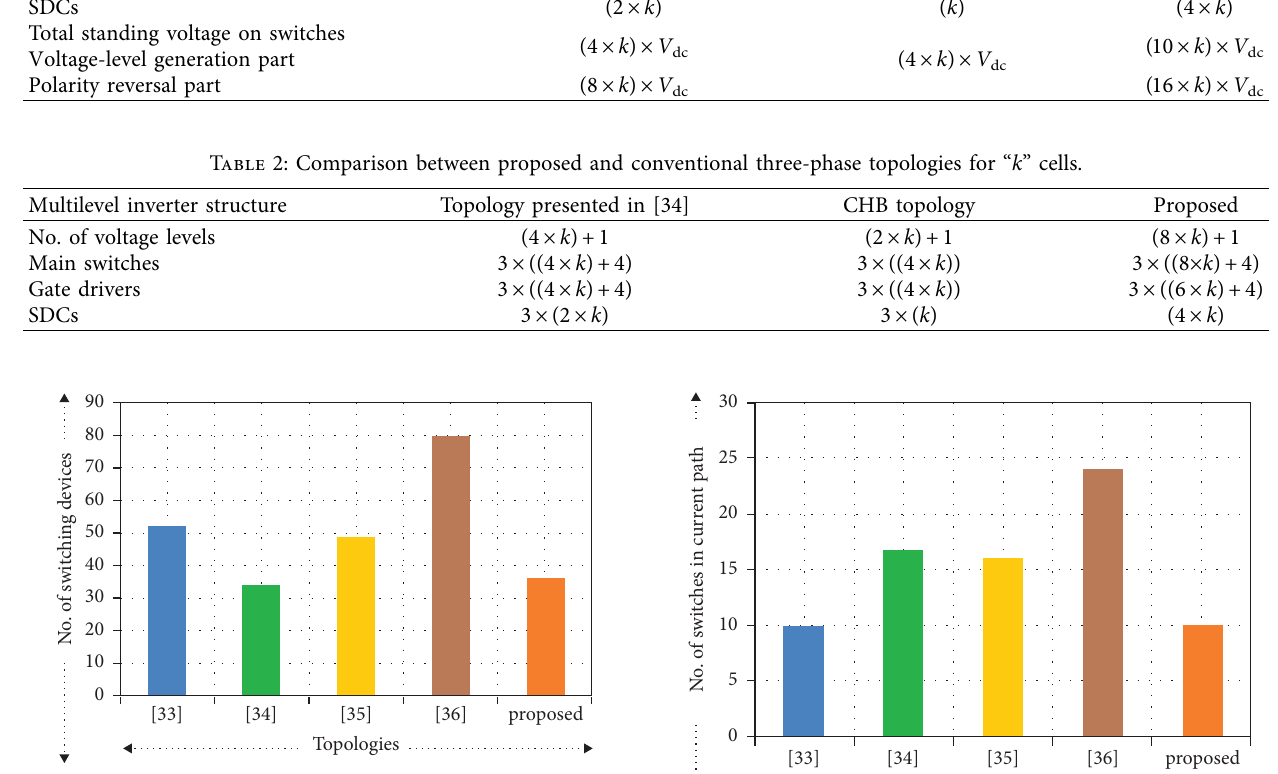
Figure 7: Comparison of number of switching devices required in recent topologies vs. proposed topology.